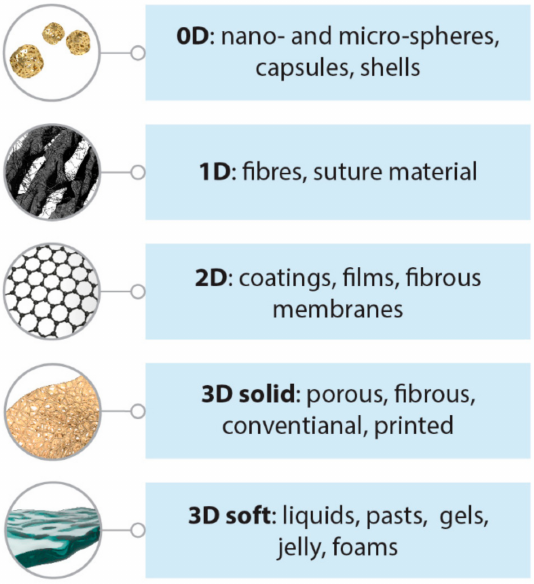
Figure 1. Different dimensionality classes of biomedical